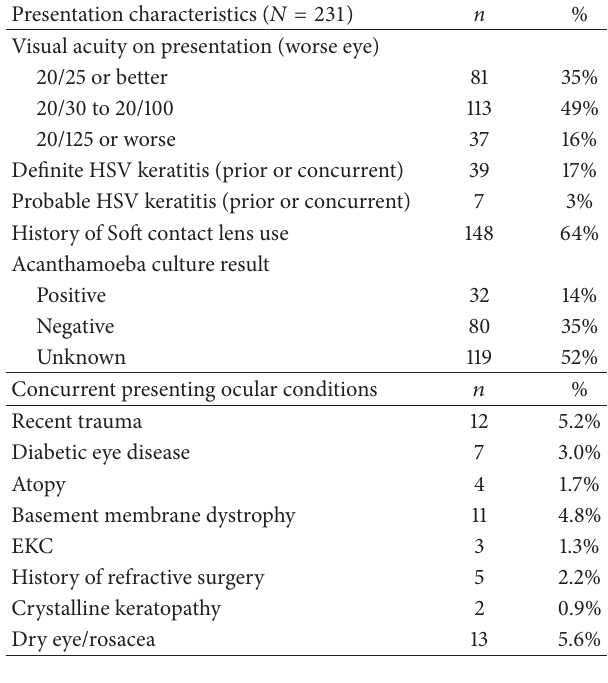
Table 2: Outcome characteristics.